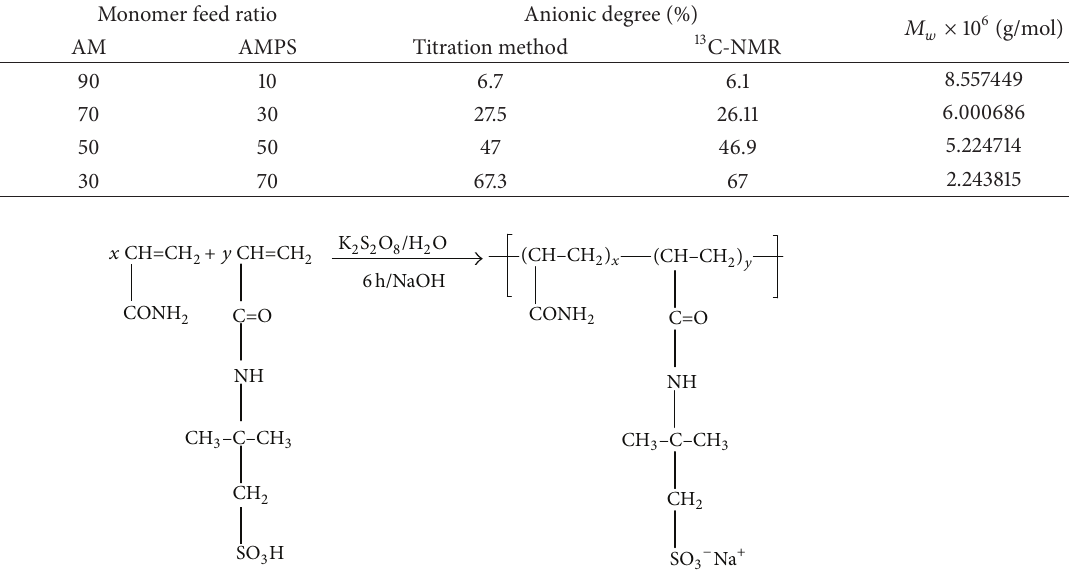
Table 1: The monomer feed ratio, the anionic degree, and molecular weight of copolymers.